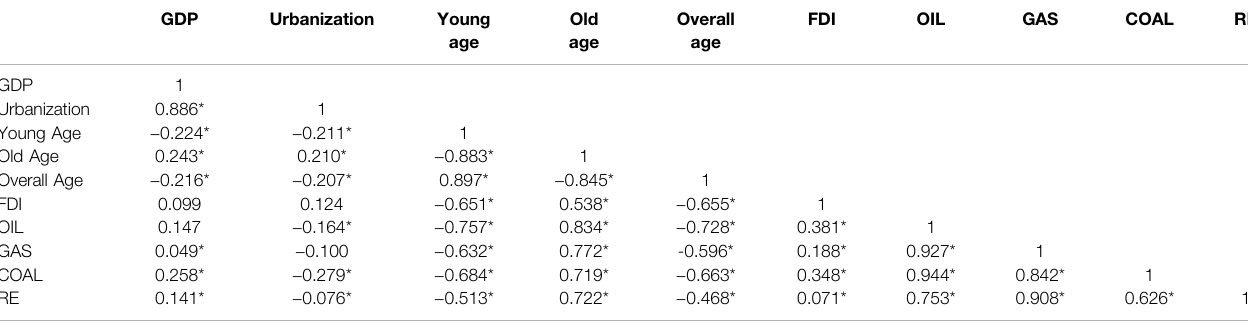
TABLE 4 | Correlation